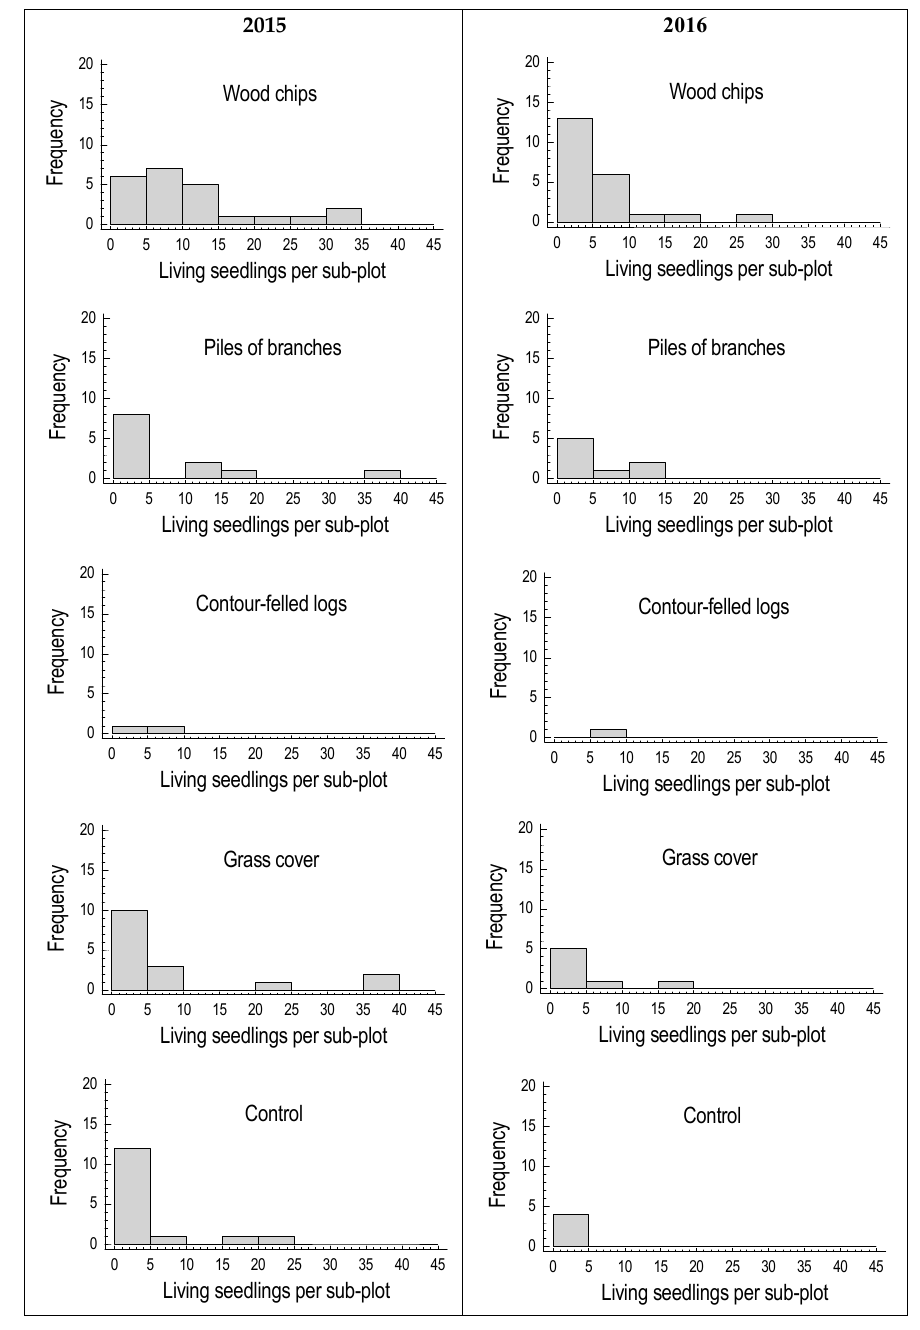
Figure 6 . Frequency histograms for the living seedlings per sub-plot in each treatment (years 2015 and 2016). Each bar represents the number of sub-plots (frequency) in each class of “living seedlings” (class size = 5 seedlings ).